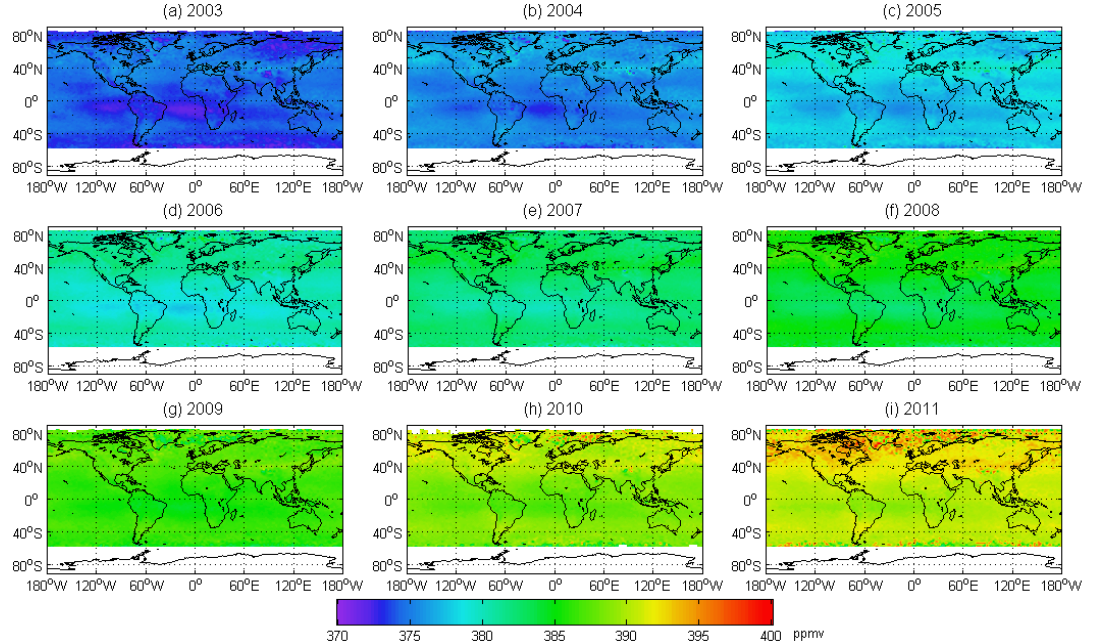
Figure 11. Global views of AIRS annual average CO 2 concentration from 2003 to 2011 as illustrated in ( a – i ), one for each year’s annual average CO 2 concentration. White regions indicate the areas with no retrievals. These figures are based on the compute and visualization of the AIRS level ‐ 3 product, which is gridded (2.5° × 2°) data, and they share the same color bar.